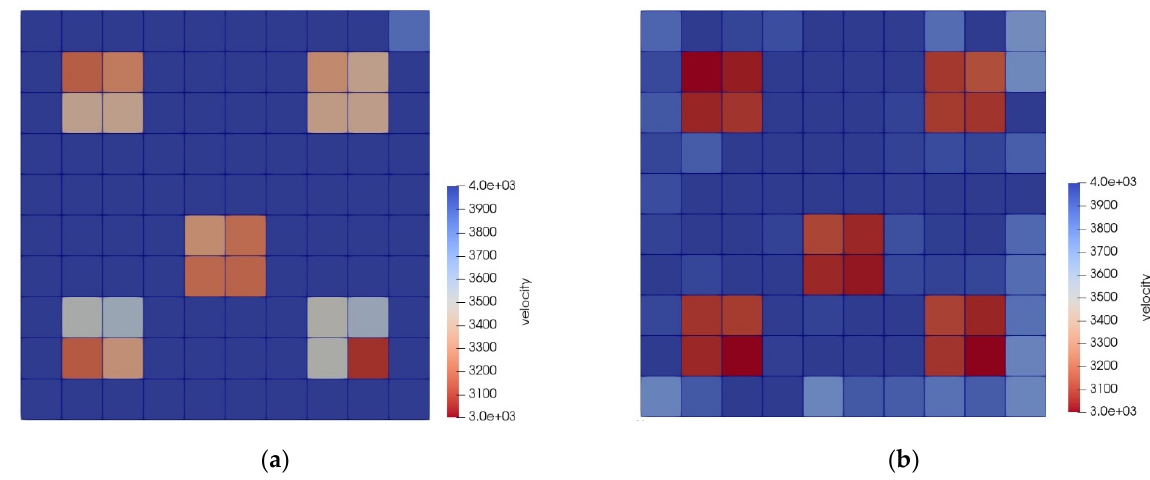
Figure 6. Identified results of the 20% defected area: ( a ) LASSO algorithm; ( b ) SIRT algorithm.